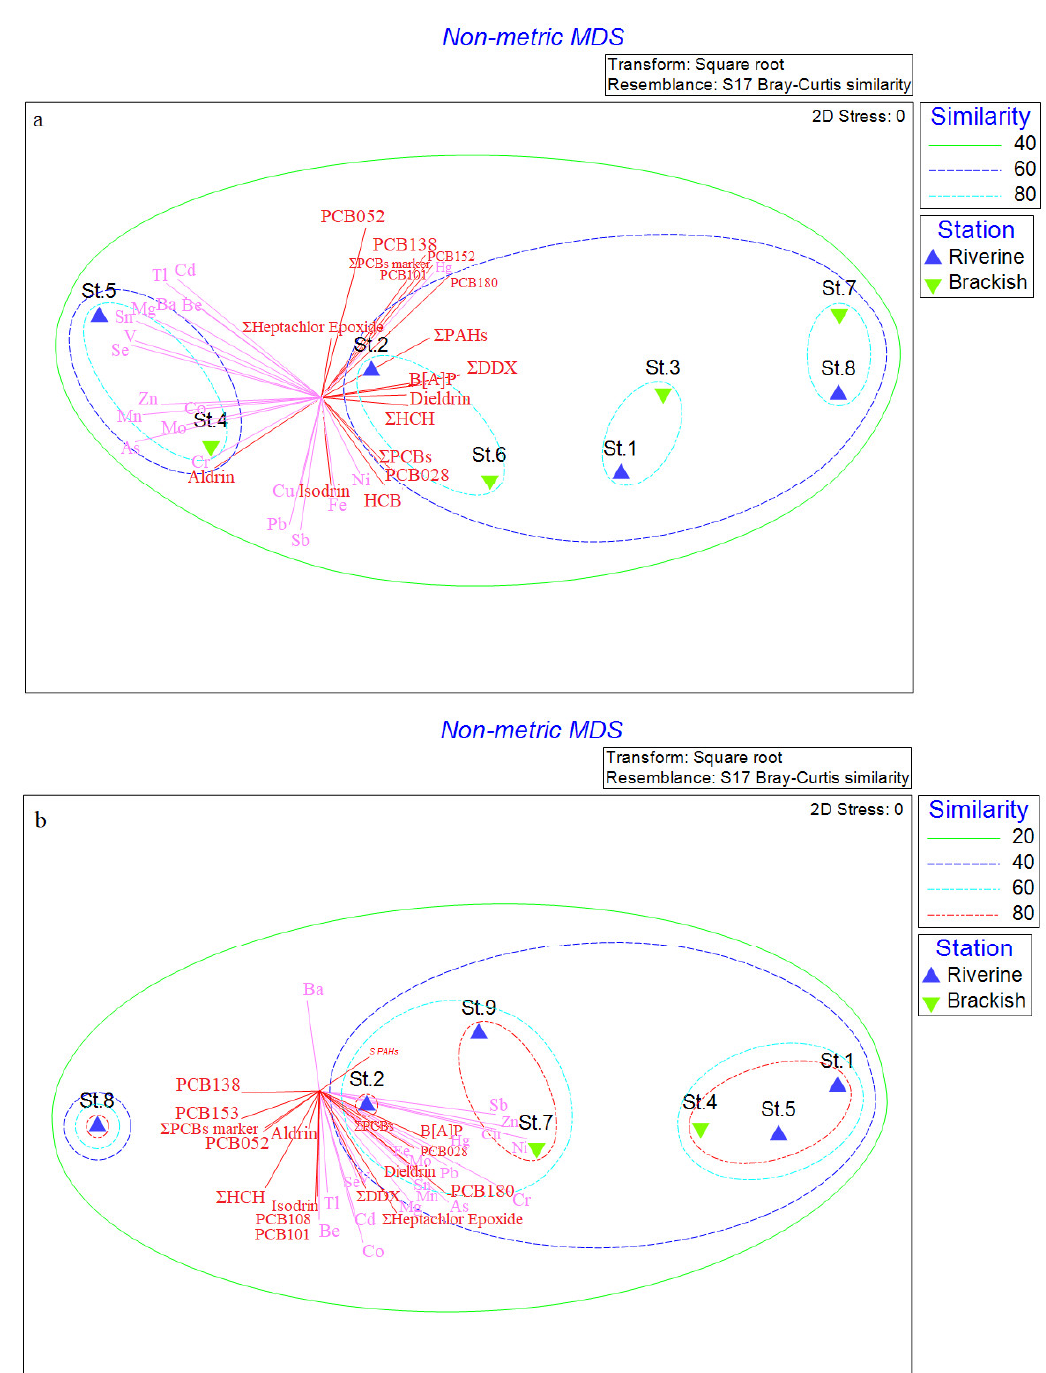
Figure 6. Non-metric multi-dimensional analysis computed microbial parameters recorded from the Pasvik River sediment during Ice-melt( − ) ( a ) and Ice-melt(+) ( b ) conditions. Vectors from inorganic and organic pollutant concentrations have been superimposed (Correlation type Pearson).